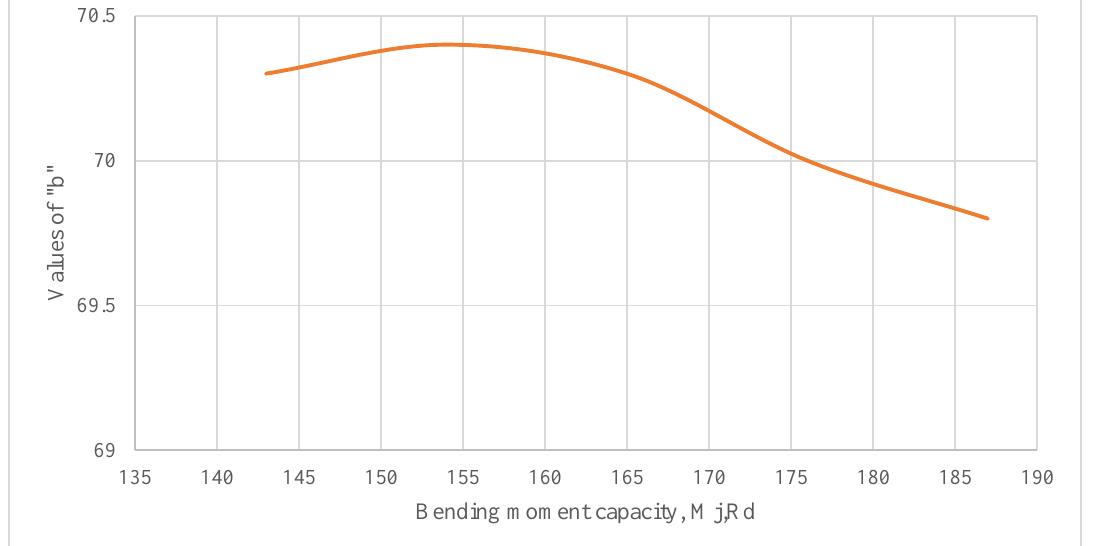
Fig. 6. Variation of RBS moment capacity vs RBS length, b.